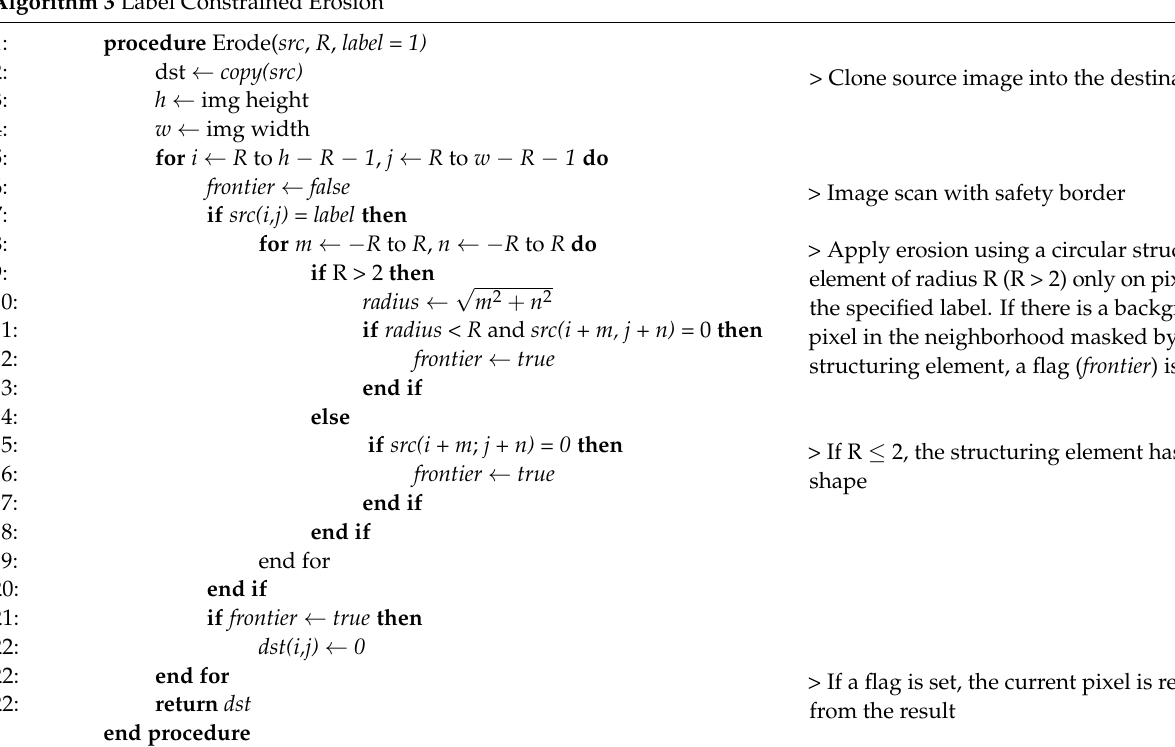
Algorithm 3 Label Constrained